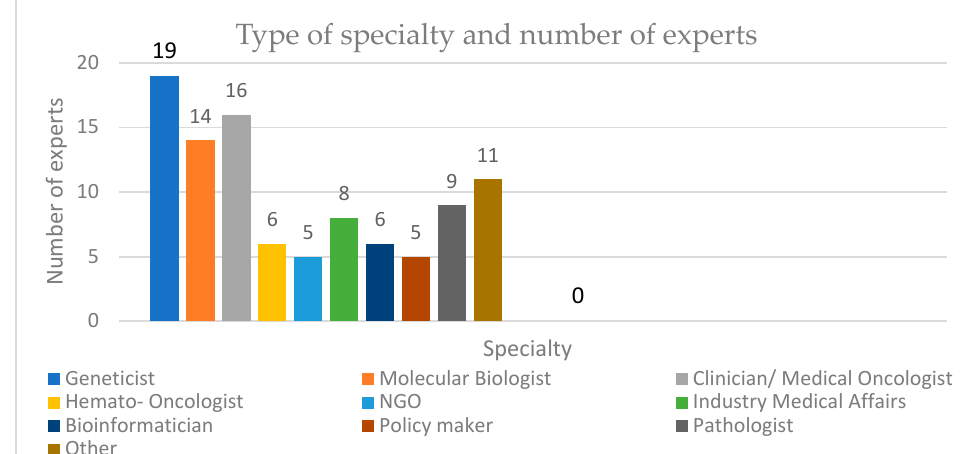
Figure 5. Respondents to the survey from different specialties.